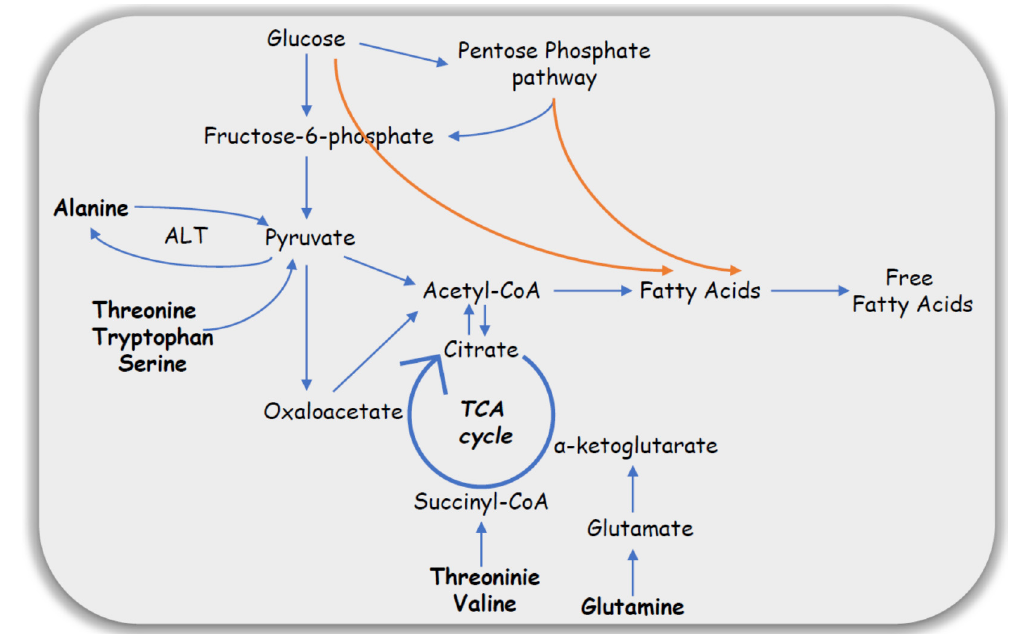
Figure 2. Alteration of glucose metabolism in PCOS.